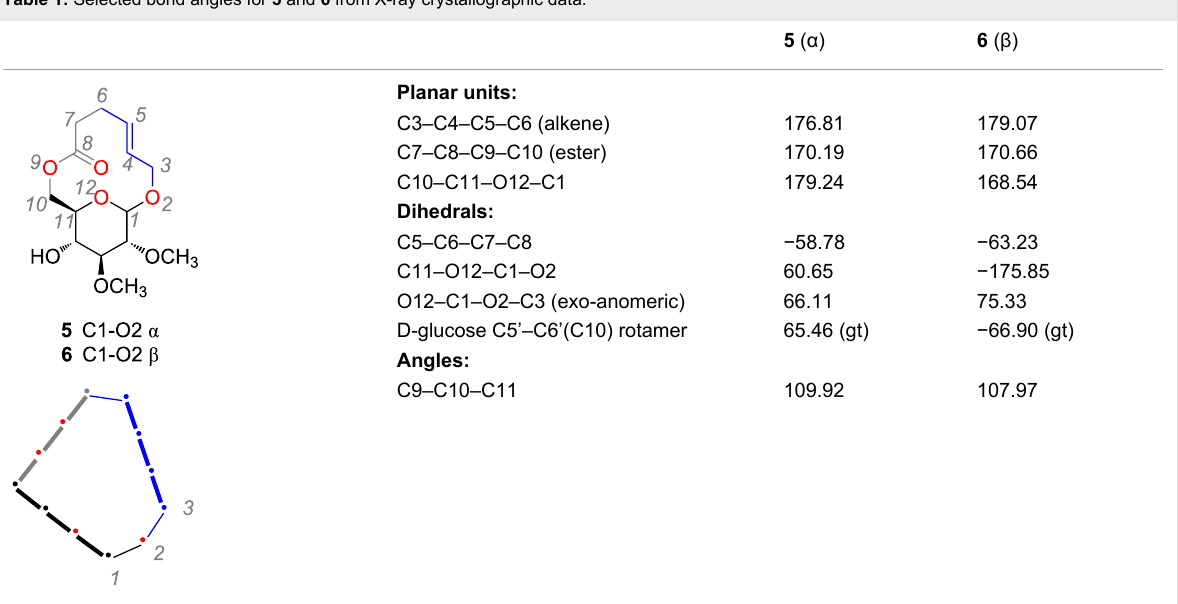
Table 1: Selected bond angles for 5 and 6 from X-ray crystallographic